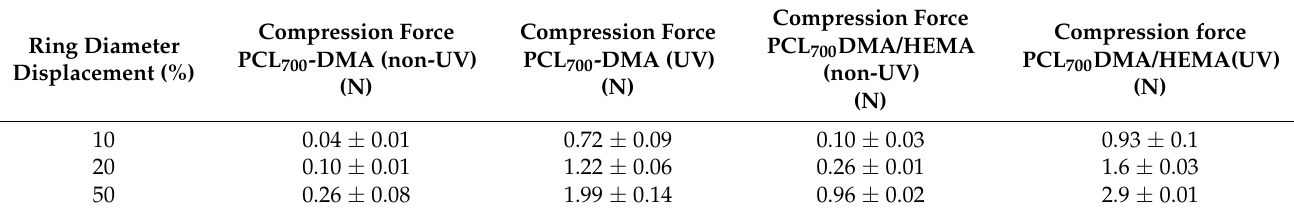
Table 4. The effect of UV-curing on 3D printed rings: Radial compression force at 10%, 20%, and 50% outer diameter compression of non-UV- and UV-cured FTS-loaded EoE rings printed with two different resin formulations (PCL 700 -DMA, PCL 700 -DMA/HEMA).